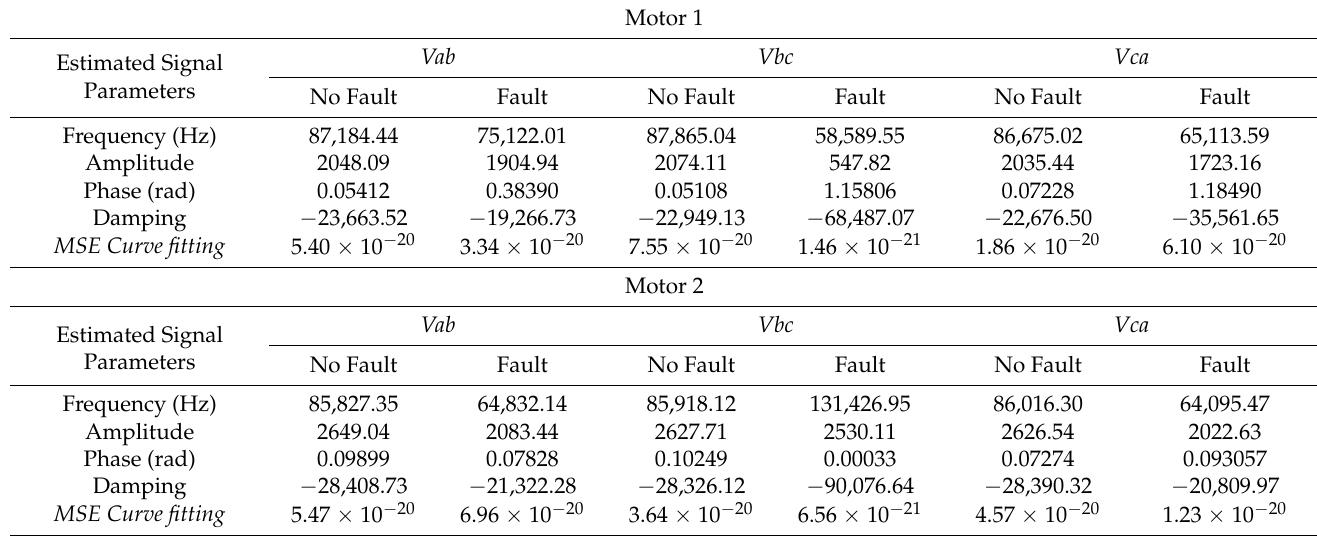
Table 6. Estimated signal parameters of recorded surge waveforms. (No fault and Fault). Motor